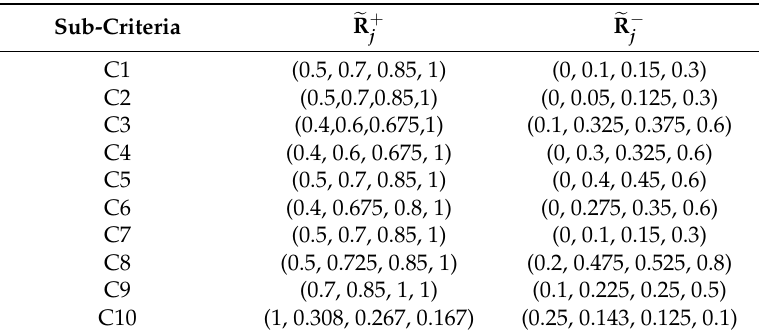
Table 19. Fuzzy ideal solutions for evaluation criteria.